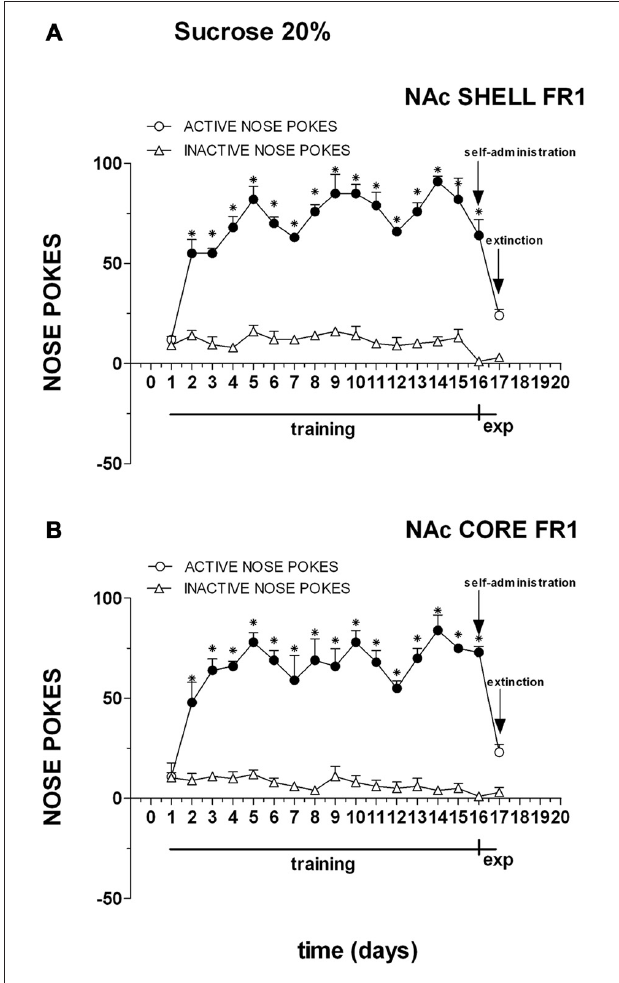
FIGURE 2 | Cumulative active (circles) and inactive (triangles) nose-pokes during training to respond for 20% sucrose under an fixed ratio 1 (FR1) schedule and during dialysis experiments. Data are means ± SEM of the results obtained in rats implanted with guide cannulas in the NAc shell (A) ( N = 4) and rats in the NAc core (B) ( N = 4). Filled symbols, p < 0.05 vs. 1st day; ∗ p < 0.05 vs. inactive nose pokes.